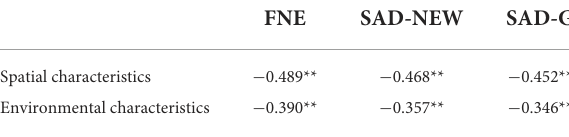
TABLE 3 Correlation results of social anxiety and spatial